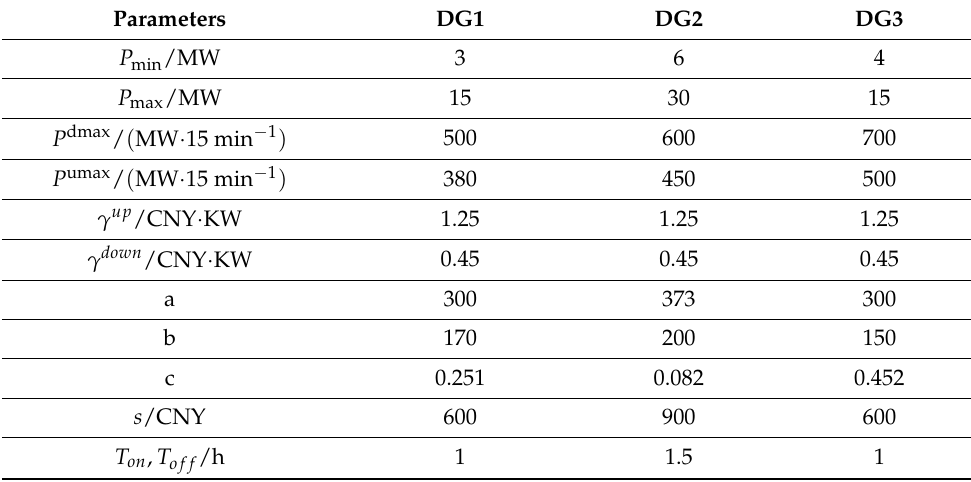
Table A2. The parameters of DGs.